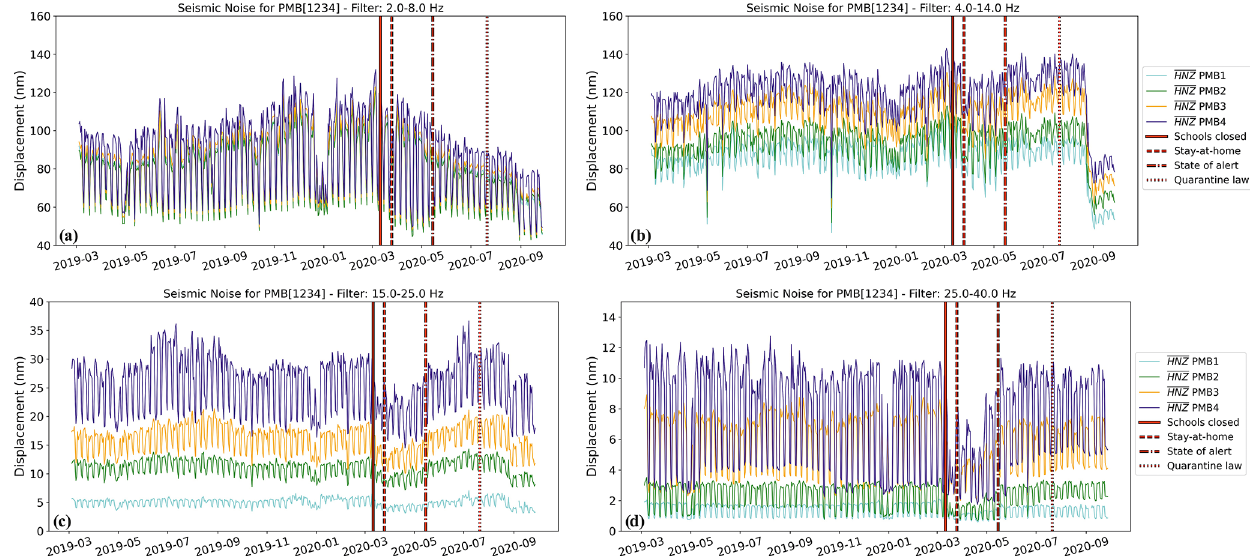
Figure 8. Long-term DRMS variations at the stations located in the Bucharest City Hall building observed in the frequency bands 2–8Hz (a) , 4–14Hz (b) , 15–25Hz (c) , and 25–40Hz (d) . Note the higher noise levels in the lower-frequency bands and the significant increase in the noise levels at the stations deployed from the ground floor to the top of the building (see Fig. 1 for the station locations).